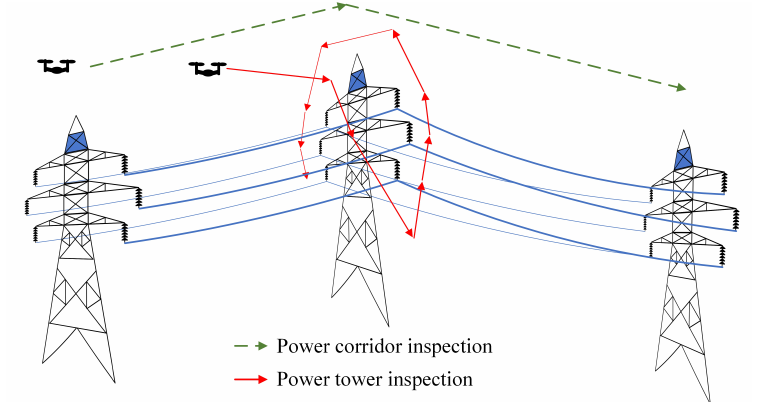
Figure 1. Diagram of power line